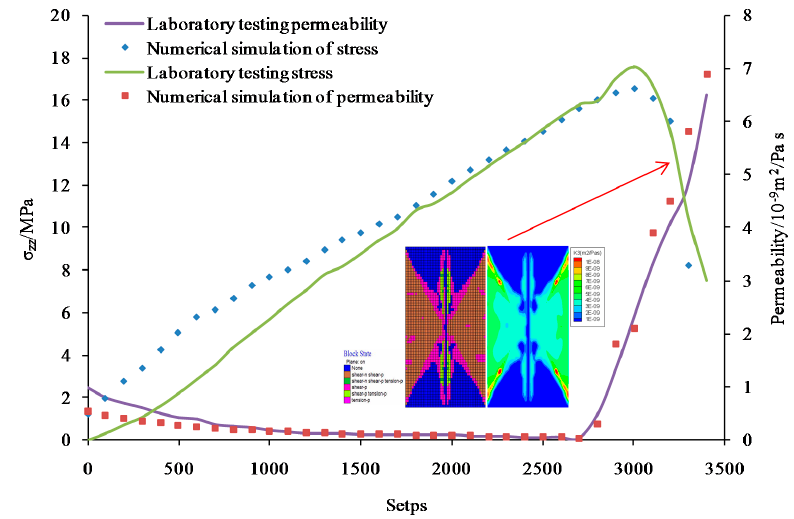
Figure 5. Modeling results of uniaxial compression and permeability-stress change curve.